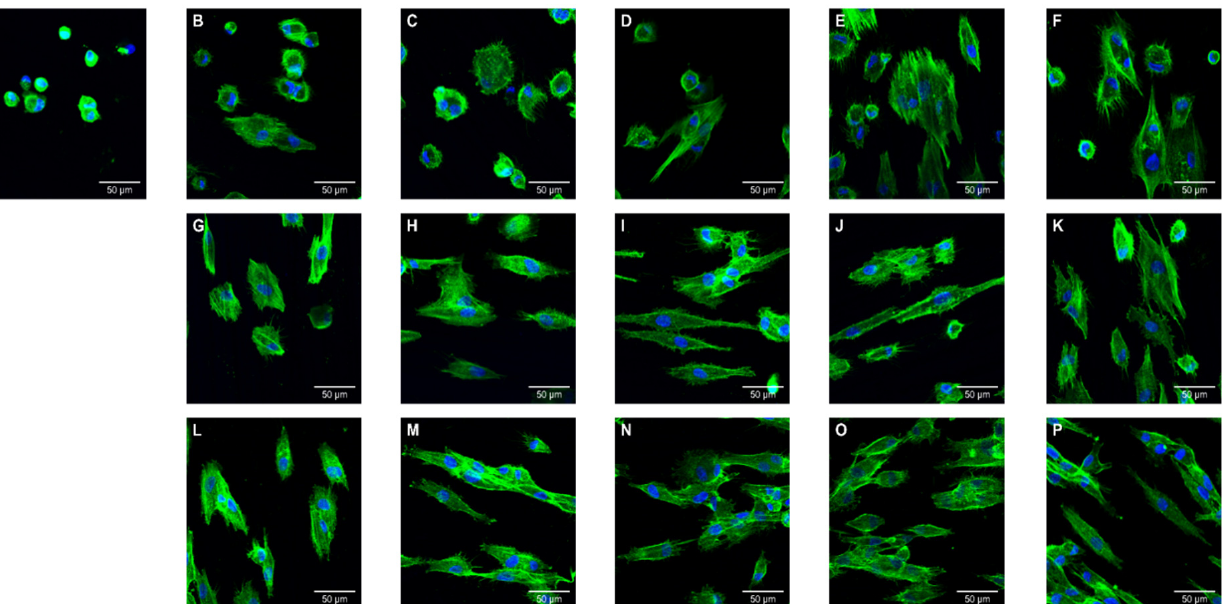
Figure 14. Confocal laser scanning microscopy (CLSM) images of human gingival fibroblasts cultures (5 × 10 4 cells/mL) on 3D printed specimens postcured at various temperature and times after 24 h of incubation: ( A ) GS, ( B ) 40 °C for 15 min, ( C ) 40 °C for 30 min, ( D ) 40 °C for 60 min, ( E ) 40 °C for 90 min, ( F ) 40 °C for 120 min, ( G ) 60 °C for 15 min, ( H ) 60 °C for 30 min, ( I ) 60 °C for 60 min, ( J ) 60 °C for 90 min, ( K ) 60 °C for 120 min, ( L ) 80 °C for 15 min, ( M ) 80 °C for 30 min, ( N ) 80 °C for 60 min, ( O ) 80 °C for 90 min, and ( P ) 80 °C for 120 min.